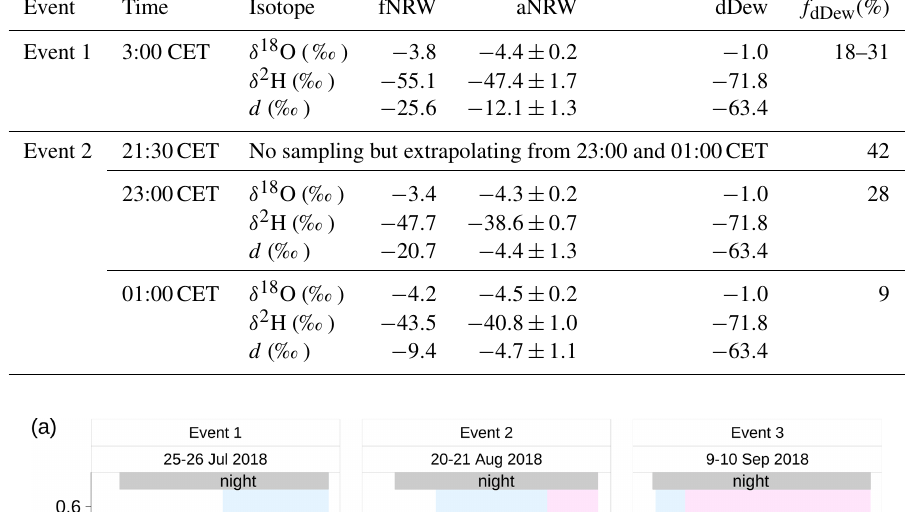
Table 1. Partitioning the contribution of distillation from a mix of distillation and aNRW. The fNRW means non-rainfall water (NRW) on foliage; aNRW represents either dew or radiation fog or dew and radiation fog in combination condensed from ambient water vapor; distillation means dew condensed from soil-diffusing vapor; f distillation means the proportion of distillation in total foliage NRW.